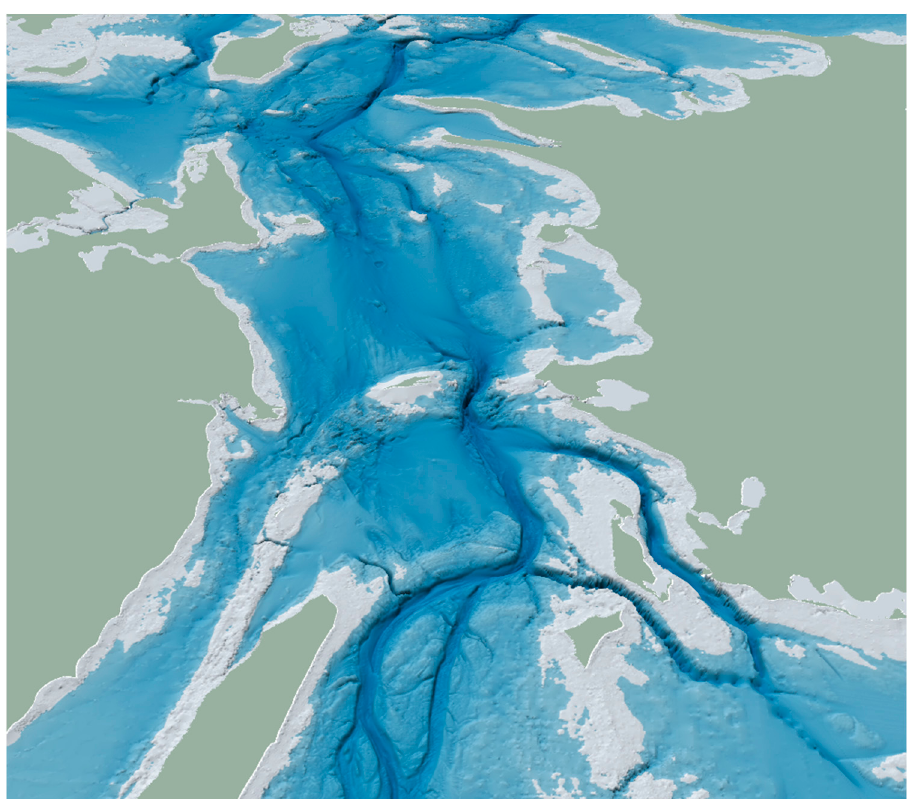
Figure 8. Perspective view of Denmark’s Depth Model at the Great Belt facing north. The area is located between the greater islands, Funen (west) and Zealand (east), and is a heavily trafficked route to the Baltic Sea. The model hill-shading is rendered using a depth exaggeration of 25 times. The maximum model depth in the area is ~70 m.